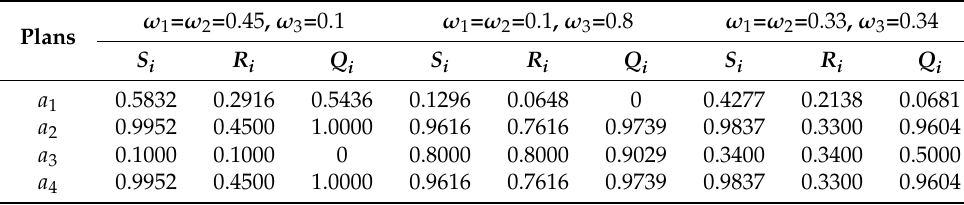
Table 15. The values of S i , R i and Q i of each scheme of the expropriator under different crite- ria